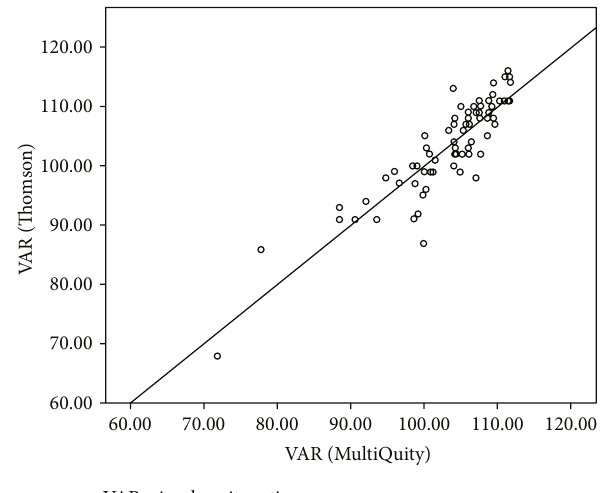
Figure 3: Agreement between visual acuity rating from the Thom- son device and estimated visual acuity rating from the MiQ device. VAR: visual acuity rating.